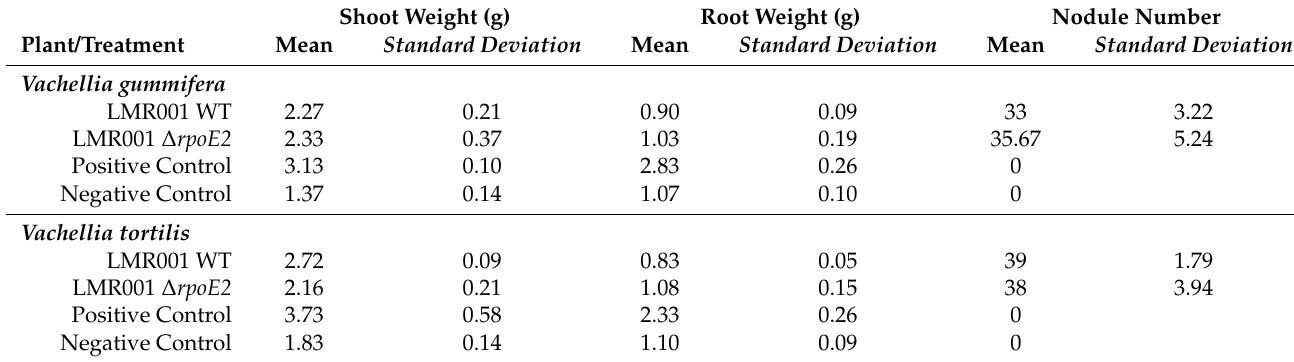
Table 2. Effect of the rpoE2 mutation on symbiosis development with Vachellia . Shoot Weight (g) Root Weight